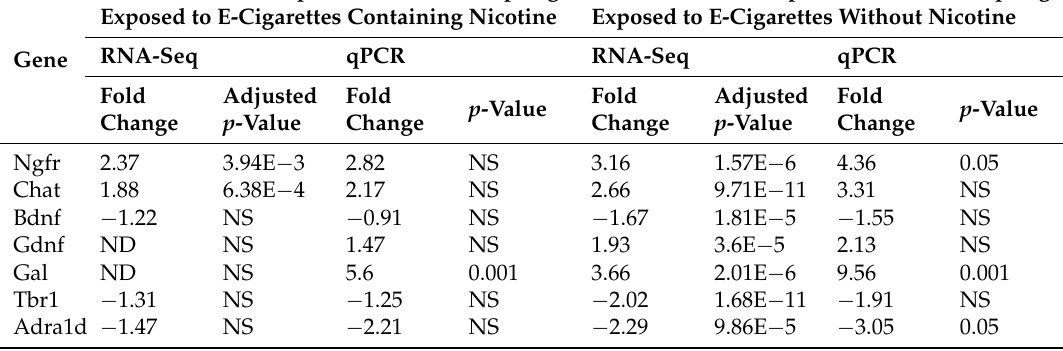
Table 2. Comparison of gene expression data from qPCR and RNA-Seq analyses. Gene expression fold-change and p -values for frontal cortex samples recovered from male offspring exposed early in life to e-cigarette aerosols with or without nicotine are compared using qPCR and RNA-Seq. Frontal Cortex Samples from Male Offspring Frontal Cortex Samples from Male Offspring Exposed to E-Cigarettes Containing Nicotine Exposed to E-Cigarettes Without Nicotine RNA-Seq qPCR RNA-Seq qPCR Gene Fold Adjusted Fold Fold Adjusted Fold p p -Value p -Value p -Value Change Change Change Change